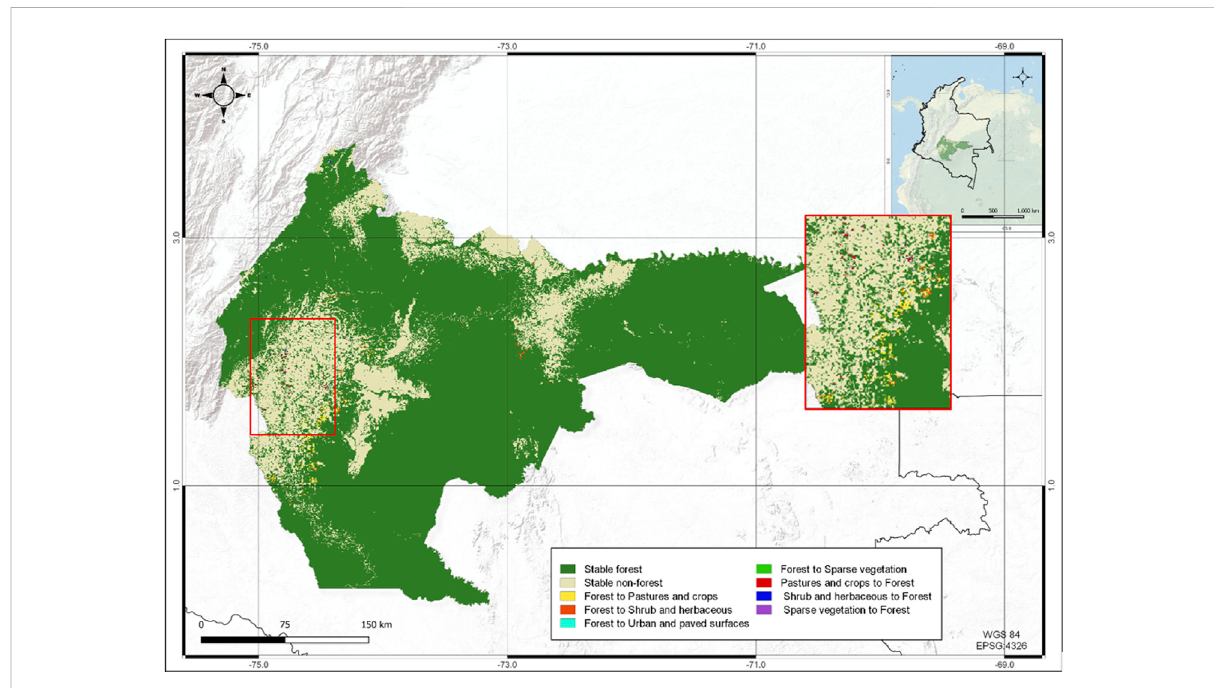
FIGURE 2 Land use land cover transitions in the study area in 2009 – 2012. Red frame: a zoom western of Sabanas del Yarí region in central Colombia.